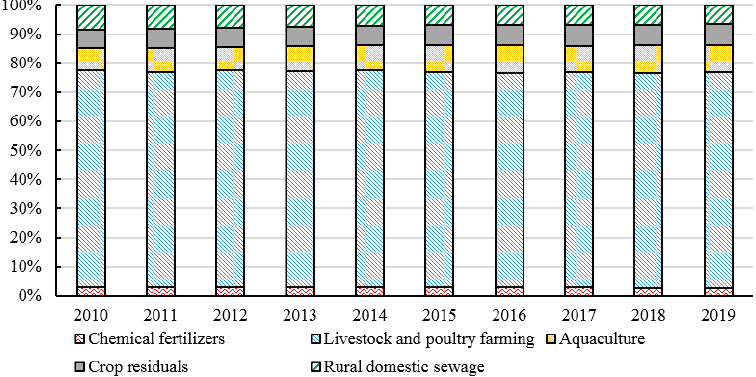
Figure 3. The proportion of TP emissions from different sources from 2010 to 2019.